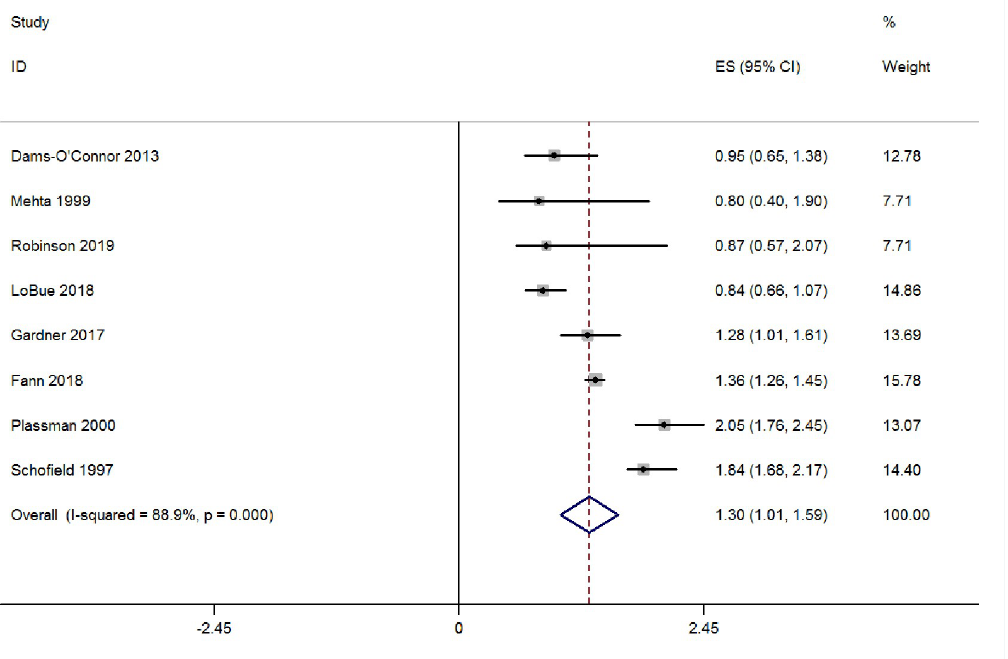
Fig 3. Forest plot of moderate/severe traumatic brain injury and the risk for AD.